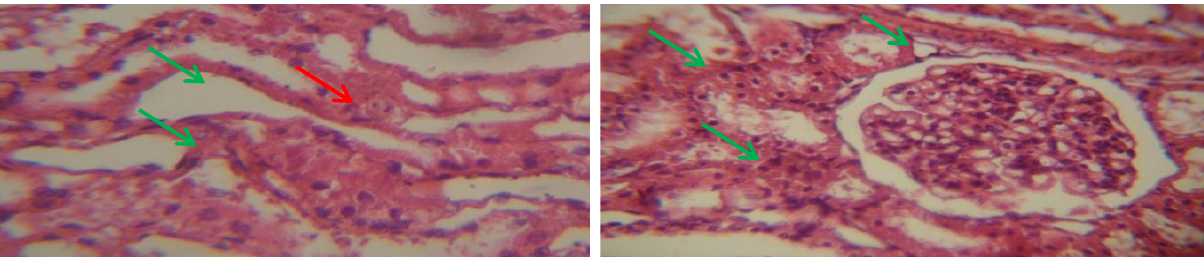
Figure 6. Section of kidney in GWZ group shows shows normal renal cortex with normal glomeruli (red arrow) and renal tubules (green arrow). H&E 100× and